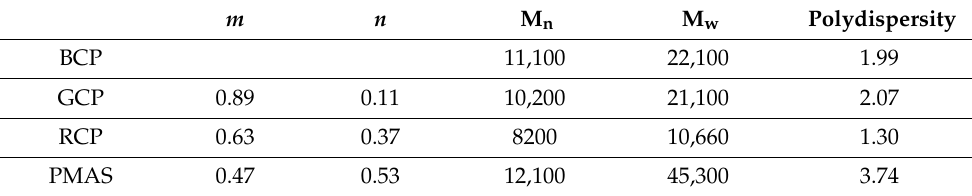
Table 1. Molar compositions a and molecular weights b of polymers.